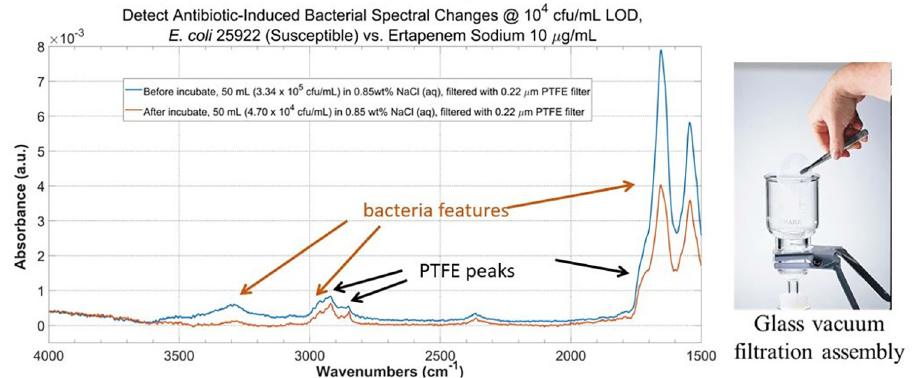
Fig 4. Sensitivity of the ATR system. Antimicrobial-induced bacterial spectral changes can be detected at 10 4 cfu/mL for an ertapenem-susceptible E . coli 25922 samples before and after incubation with 10 μ g/mL ertapenem sodium at 10 4 for 4 hours at